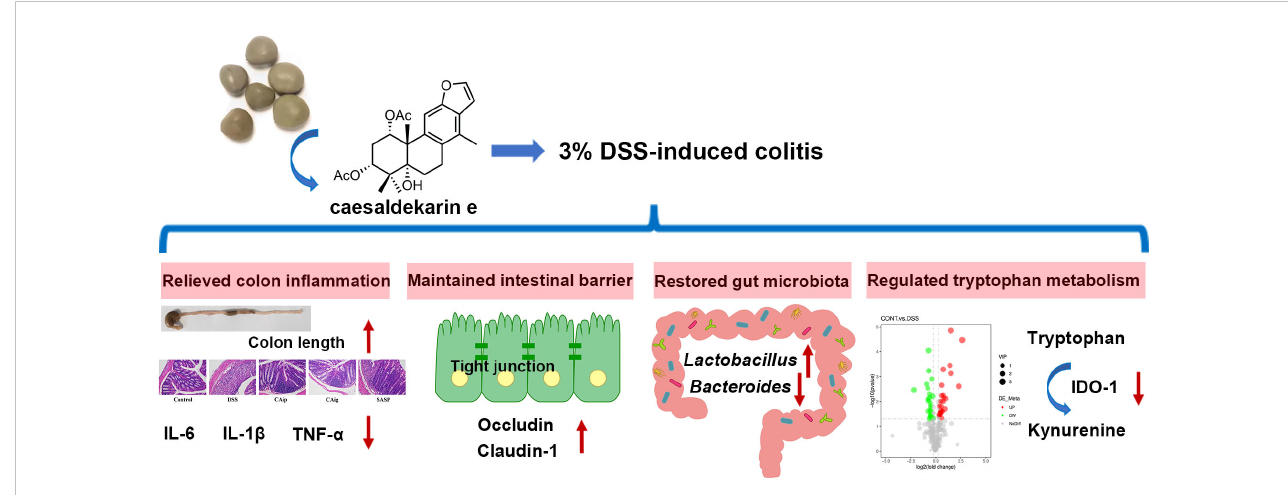
FIGURE 9 Graphical abstract of this article. The up arrow ( ↑ ) and down arrow ( ↓ ) represent upregulation and downregulation effects of CA, respectively.